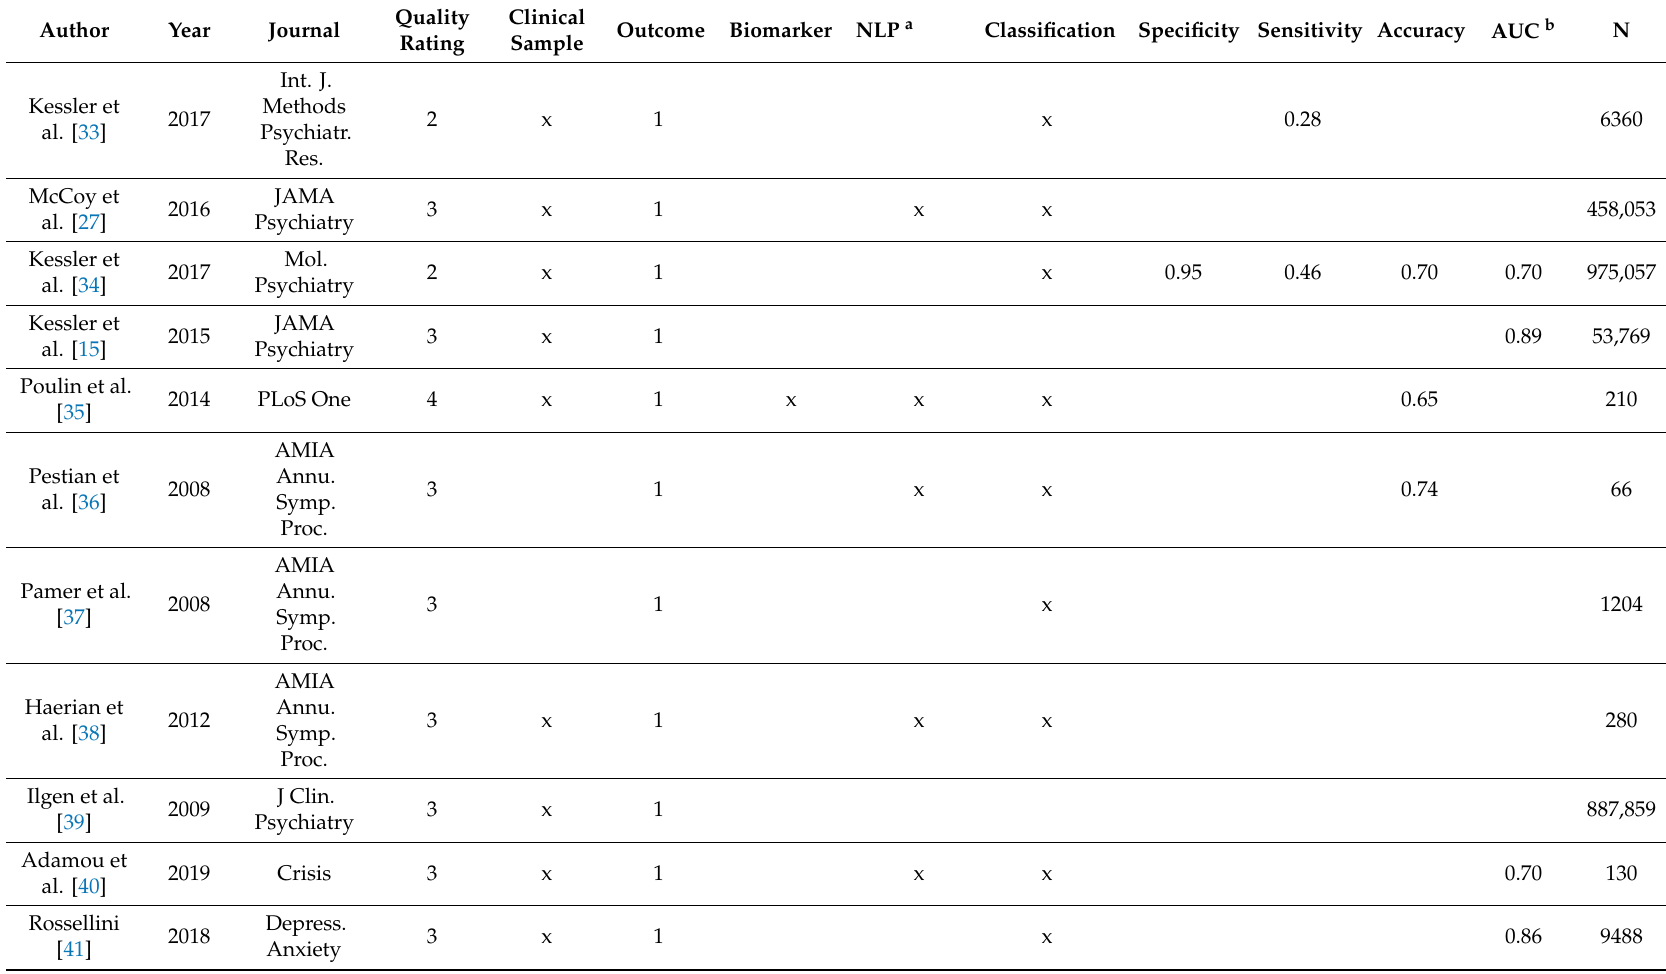
Table 1. Investigations by broad outcome groupings and ML